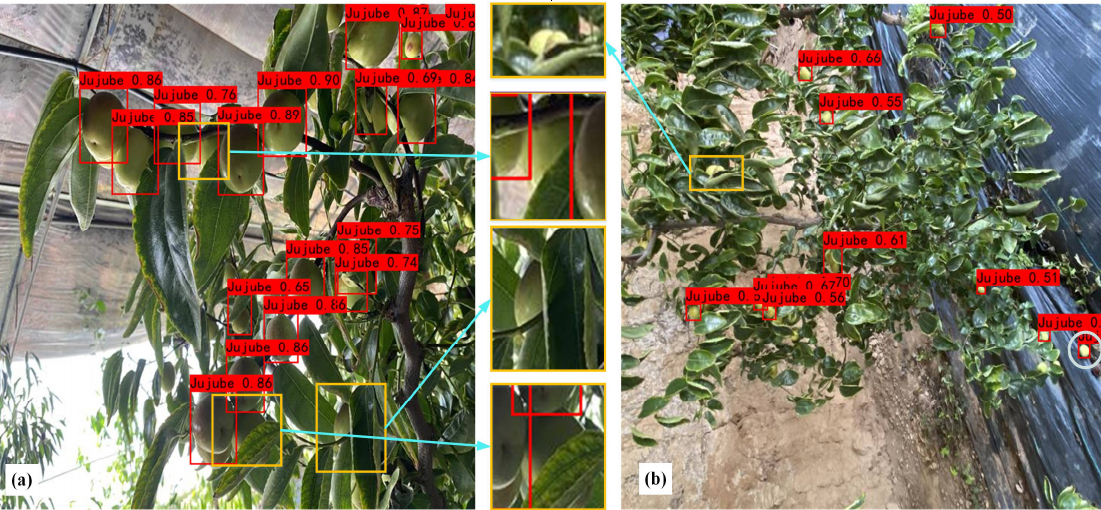
16 of 20 Figure 13. Performance analysis under different illuminations. 4.2. Failure Samples Analysis Typical failure samples that cannot be detected under backlit and occlusion scenes (yellow box) are shown in Figure 14. The reason for these phenomena is that the coexist-